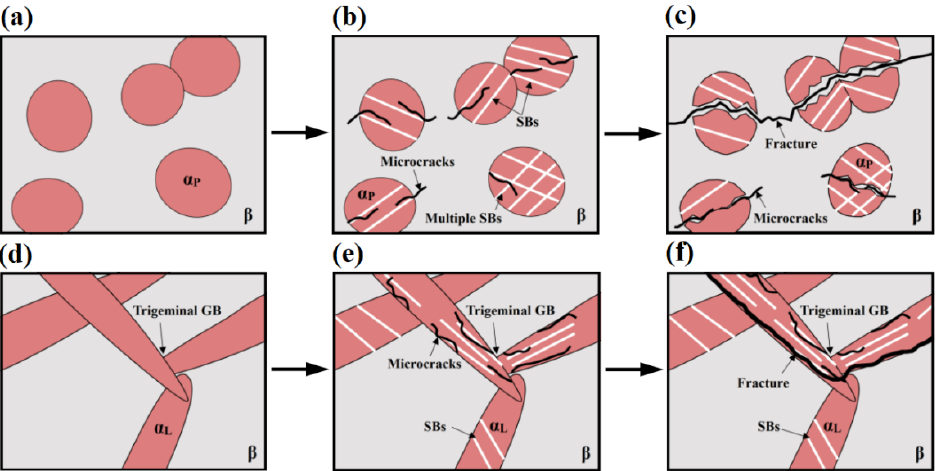
Figure 14. Schematic diagram showing the microstructure evolution of Ti-55511 alloy during stretching in situ; ( a – c ) bimodal microstructure evolution; ( d – f ) lamellar microstructure evolution. With the cyclic-loading processes, microcracks first initiated within the region of the α P phase due to the repeated dislocation slipping along certain slip planes (Figure